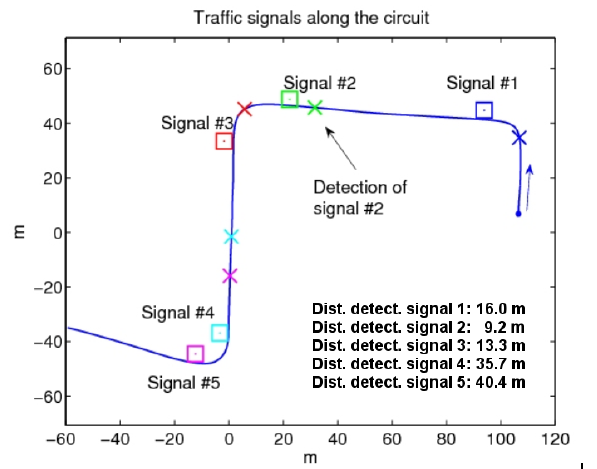
Figure 9. Circuit for vehicle control experiments and positions (  ) of the five speed limit signals. The X marks indicate the positions in the road where the corresponding traffic signals are first detected by the RFID readers on the